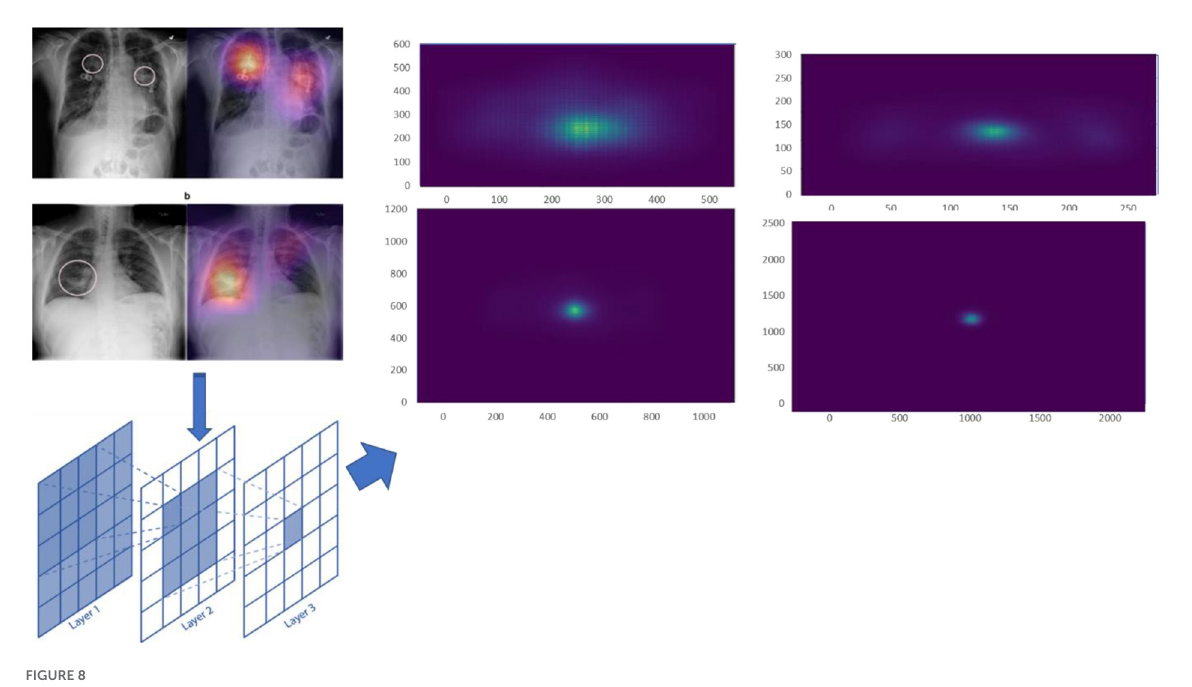
FIGURE8 A trained Dense’et121’s ERF.